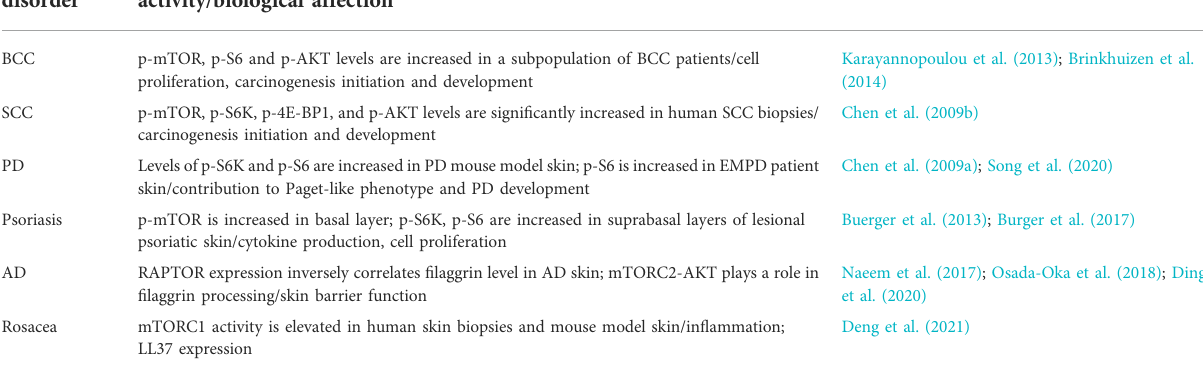
TABLE 1 Dysregulated mTOR signaling in various skin